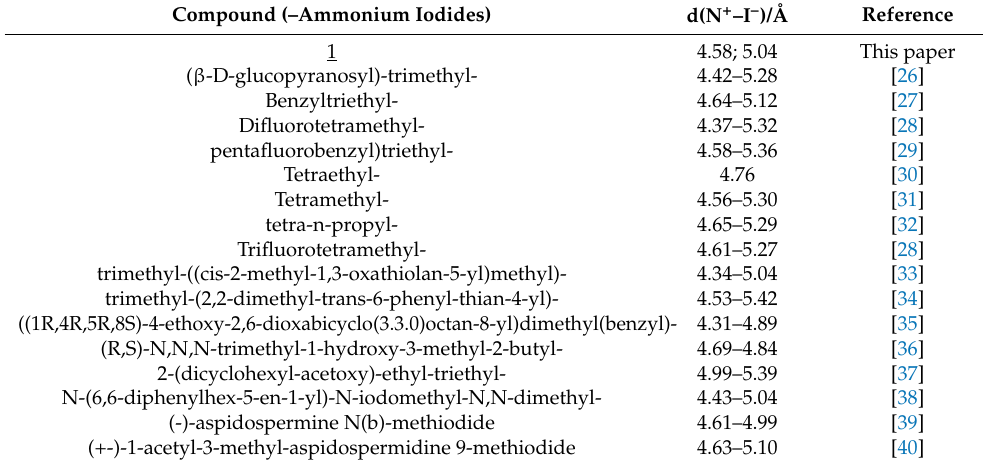
Table 2. The distances found between an iodide ion and the charged nitrogen atom corresponding to the electrostatic interactions in ammonium iodide crystals.